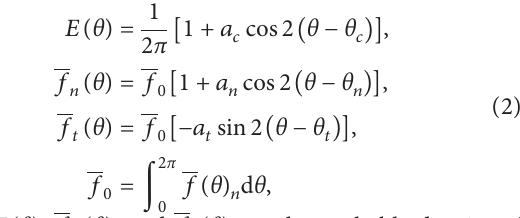
� 15kPa;(b) σ � 35kPa;(c) σ � 55kPa;(d) σ � n n n